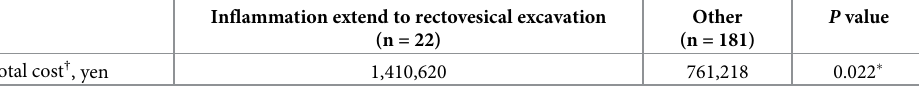
Other P value (n = 181)